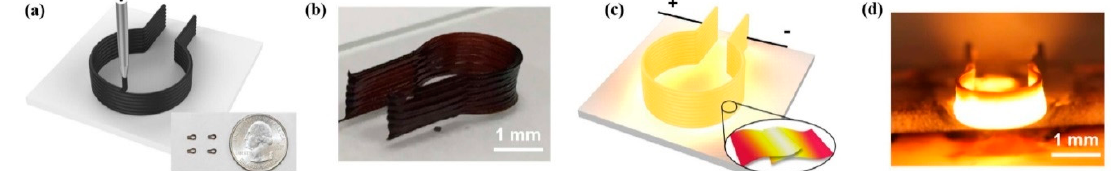
Figure 17. Schematic demonstration of the 3D printable heater. ( a ) 3D printing of RGO heater. The inset has 4 heaters shown with a size of 1.5 mm. ( b ) The image of the as-printed 3D heater. ( c ) The RGO heater achieves temperatures above 3000 K when a driving current is applied. ( d ) image of 3D printed heater at high temperature. Adapted from [28], with permission from American Chemical Society, 2016.